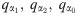
Model assumptions and simulation result.(A, B) Self-activation and self-inhibition loops of histamine via a mast cell, and the detailed functions of the loops. The example graphs are drawn for γ = 0.008, α1 = 0.4, α2 = 5.0 in model (1). (C) A representative simulation result of the model (1) for wheals and histamine. The parameter is assigned to Table 1 (Set I). The initial condition is shown in the figure at t = 0 for histamine. (D-G) Parameter spaces for wheal development with respect to Pmin are plotted by the color bar. Uniform development is the region where wheals are uniformly developed in the area corresponding to no pattern state. Fine-tuning is the region where wheals developed as very fine dots with diameters less than 3 mm and were widely spread over the area corresponding to eruptions shown in Fig 3. q0, qα1,qα2,qα0, qμ, qγ, qF, qU are labels of parameter values chosen in the simulation results in (Fig 3A–3F).